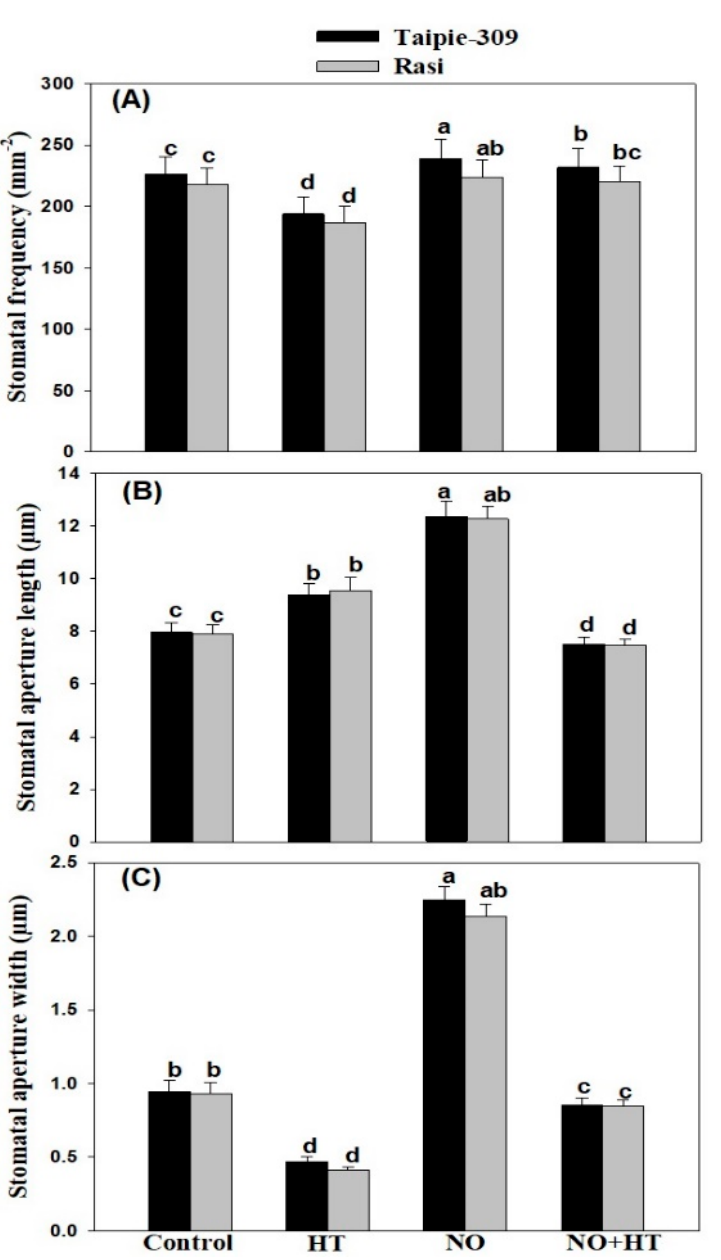
Figure 7. Stomatal frequency ( A ), stomatal aperture length ( B ), and width ( C ) in Taipie-309 and Rasi cultivars of rice ( Oryza sativa L.) at 30 days after germination (DAG), plants were grown with/without high temperature stress and treated with foliar 100 µ M SNP (NO donor). Data are presented as treatments mean ± SE (n = 4). The values followed by same letters above bars represent that data did not differ significantly by LSD test at p <